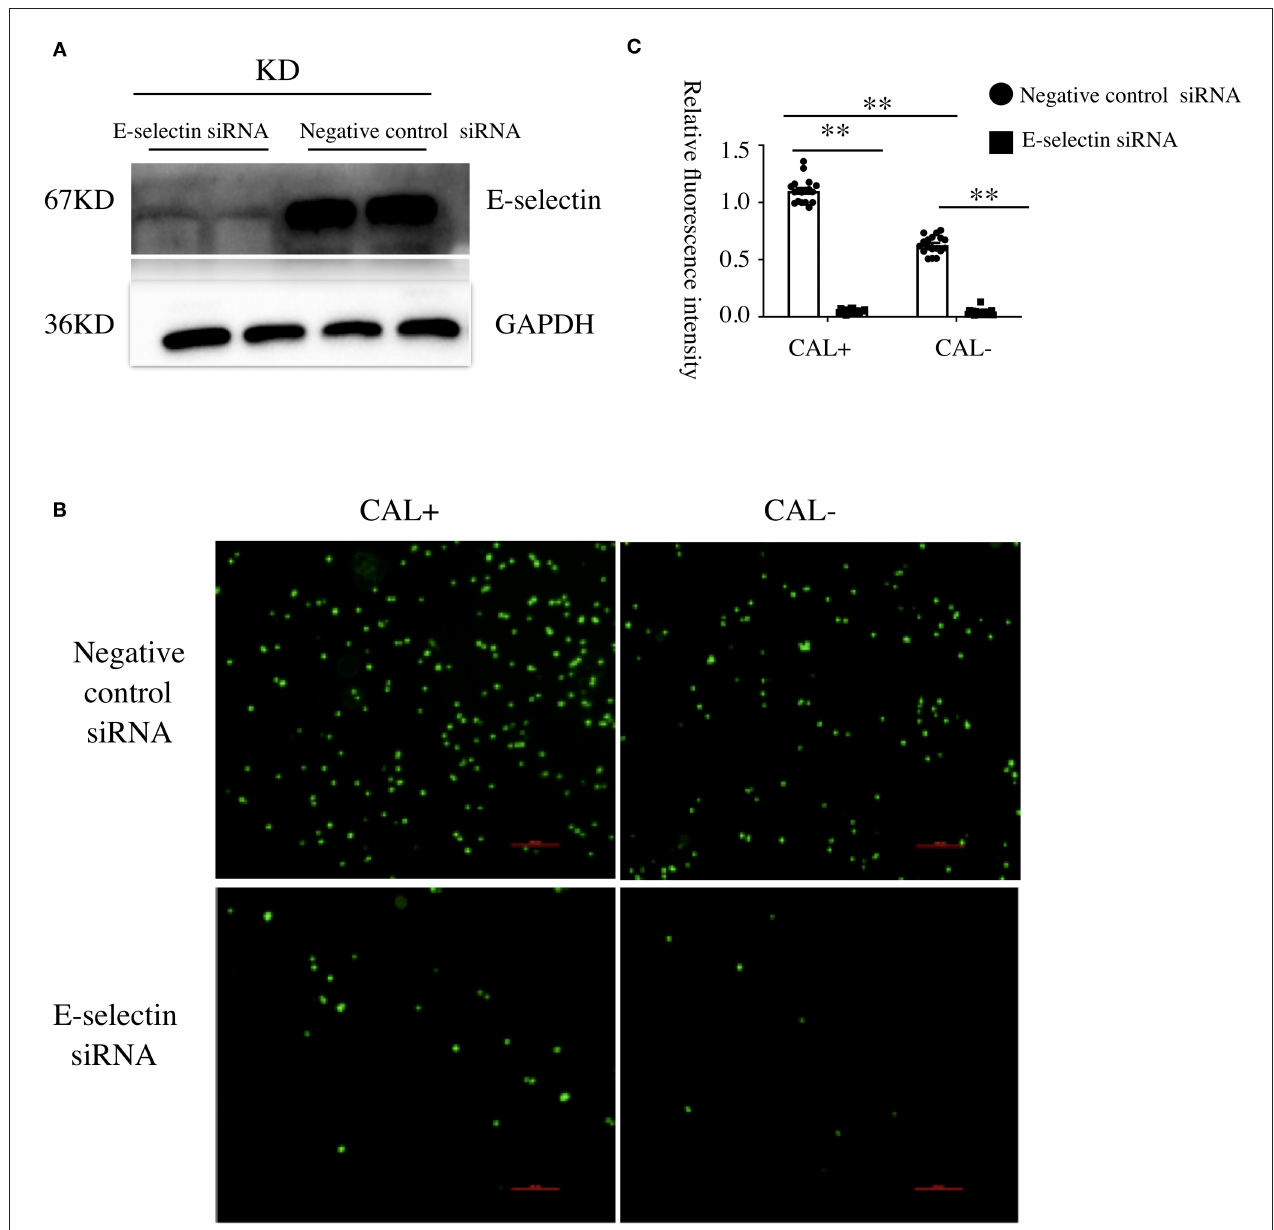
FIGURE 2 | E-selectin was involved in Kawasaki disease (KD) endothelia–monocyte interactions. Human coronary artery endothelial cells (HCAECs) were treated with specific E-selectin siRNA (100nM) or negative control siRNA (100nM) for 72h, followed by medium containing 15% sera from KD-CAL– ( n = 6) and KD-CAL + ( n = 6) subjects for 4h. Changed the medium to Hank’s balanced salt solution with HEPES buffer (HHBS) and incubated with 2 ′ ,7 ′ -bis-(2-carboxyethyl)-5-(and-6)-carboxyfluorescein acetoxymethyl ester (BCECF-AM)-labeled THP-1 cells for 1h, then the suspended cells were washed with phosphate buffered saline (PBS). (A) The effects of siRNA (pooled from three KD subjects). (B) Representative images used quantification of THP-1 cells (green, BCECF-AM) attached to human umbilical vein endothelial cells (HUVECs). (C) Quantitative analysis of adherent THP-1 cells lysate fluorescence at 490-nm excitation and 530-nm emission. All samples were normalized to HCAECs with CAL serum treatment. The bar graphs are mean ± SEM. ** P < 0.01 compared with the indicated